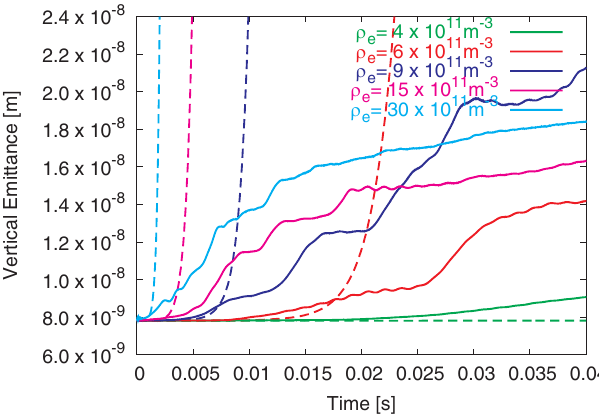
FIG. 16. (Color) Wakefield induced by an electron cloud ( (cid:2) 6 (cid:6) 10 11 m (cid:4) 3 ), in LHC at injection. The red curve is from a HEADTAIL simulation, while the other lines represent the ana- lytical expression (5) of the